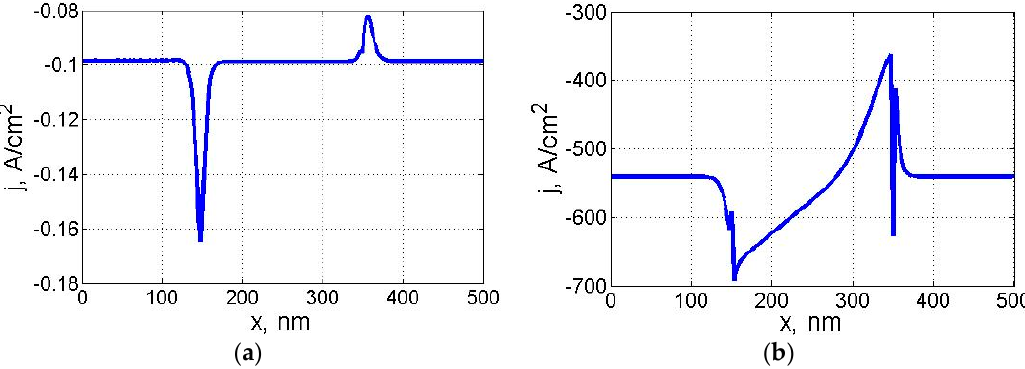
Figure 6. Spatial distributions of the current density flowing through the GaAs p-i-n photodiode